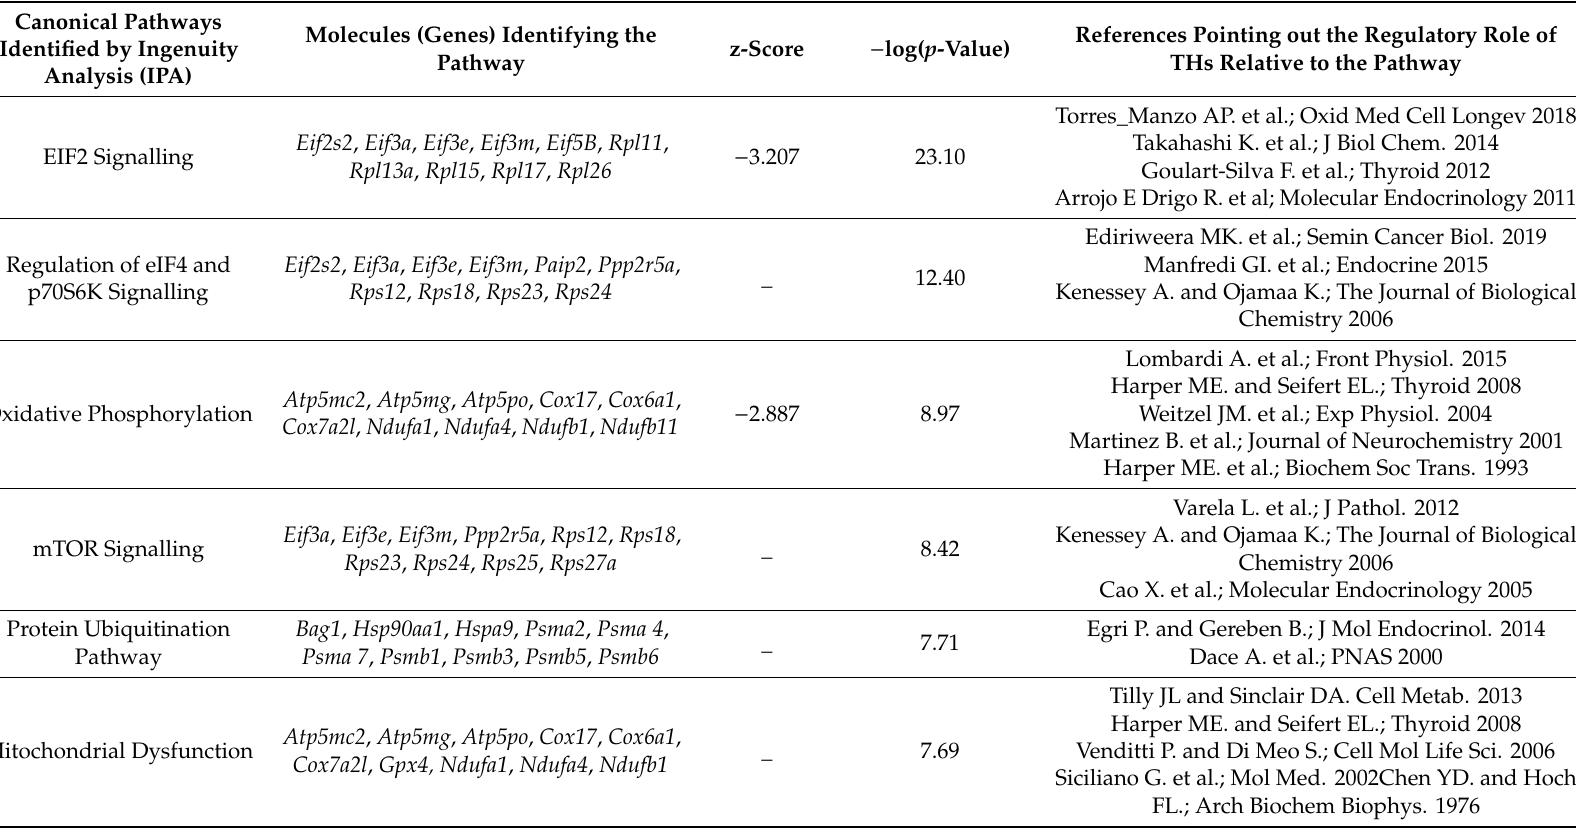
Table 1. Canonical pathways, targeted by THs, a ff ected in physiological ovarian ageing. IPA analysis of microarray data, previously published (Cuomo et al., 2018), mapped nine top biological processes altered during physiological ovarian ageing. They are listed together with the deregulated genes that contribute to their identification. The statistical relevance, the activation status, and the regulatory role of THs of the pathways are reported as − log( p -value), z-score, and citations,